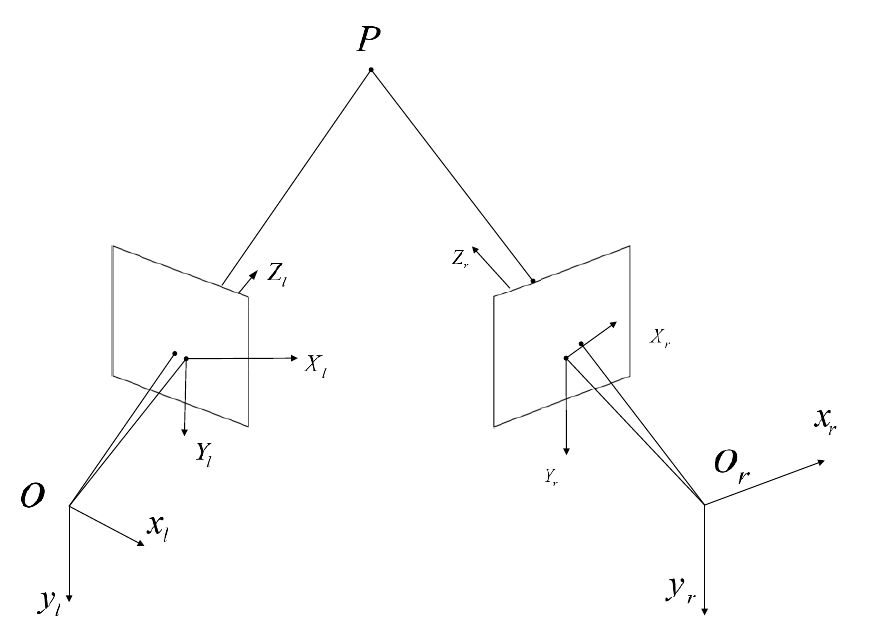
Figure 3. Binocular stereo vision 3D coordinate monitoring.